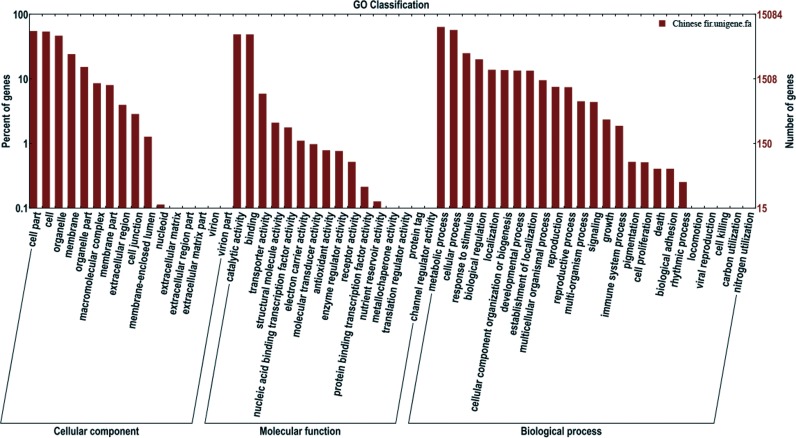
Functional annotation of assembled sequences based on gene ontology (GO) categorization.GO analysis was summarized into three categories: cellular component, molecular function and biological process.